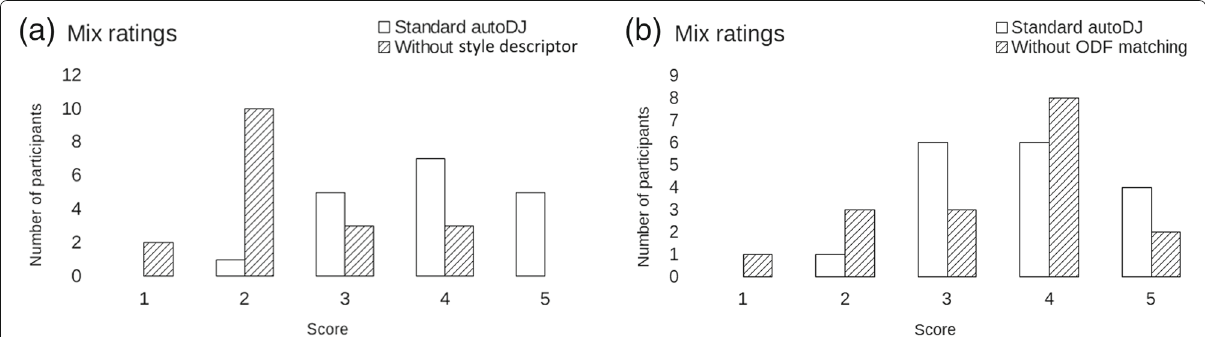
Fig. 12 User test results: comparison of the ratings by the users. a Style descriptor track selection vs. style-agnostic track selection. b Automatic DJ vs. song selection of worst matching songs in terms of ODF overlap